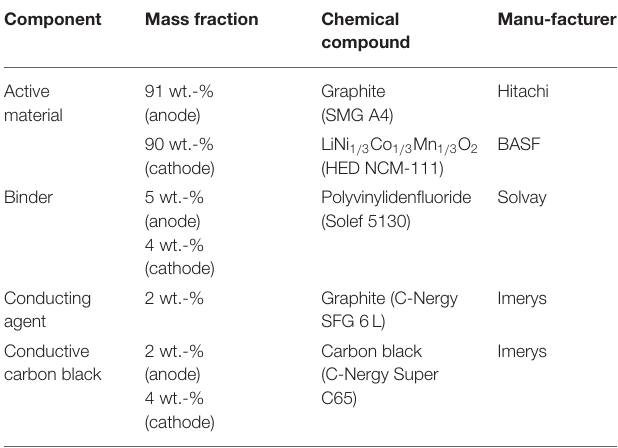
TABLE 1 | Electrode composition of the investigated lithium-ion battery.